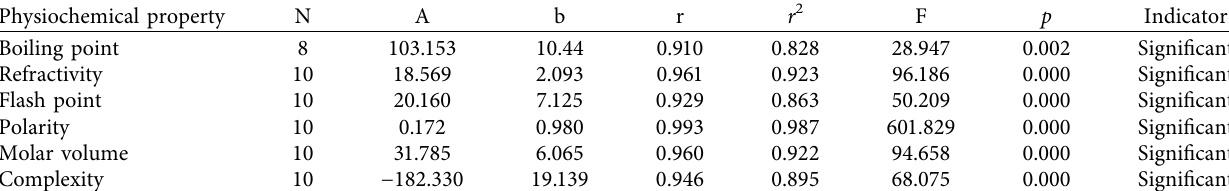
Table 3: Statistical parameters used in the QSPR model of ABC(G).